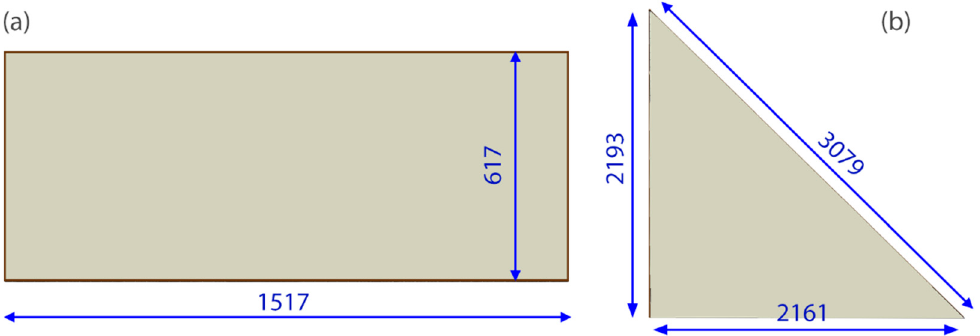
Figure 4. Overview of warm edge system: ( a ) schematic of the model ( b ) photo of the actual cavity space with primary and secondary seals.